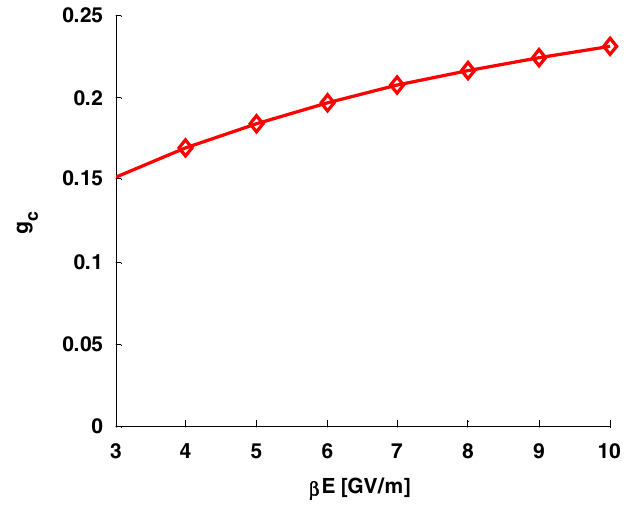
on the FIG. 13. (Color) Distribution of S c of the structure number 3 from Table I is taken as an